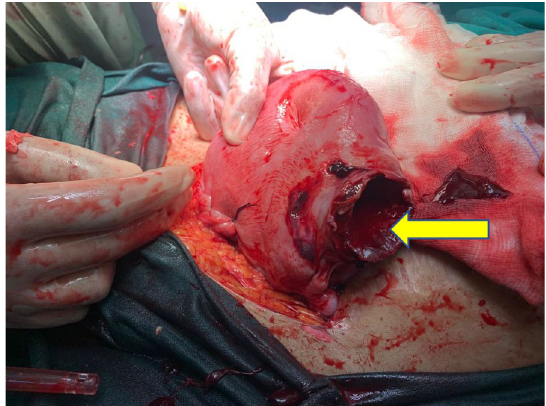
Fig. 2 Intraoperative image showing cornual